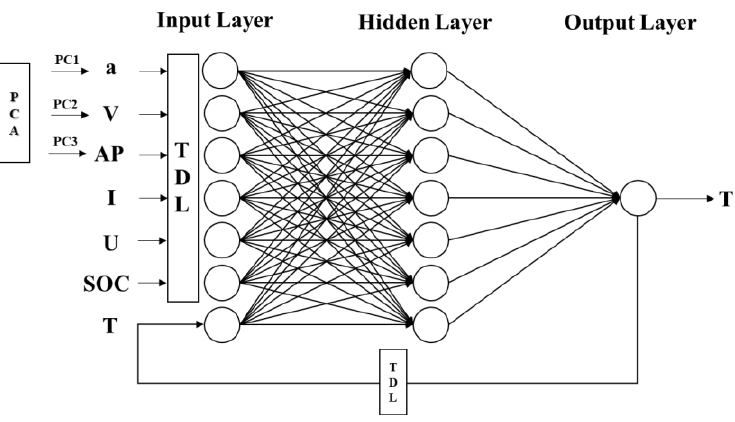
Figure 15. NARX neural network framework.